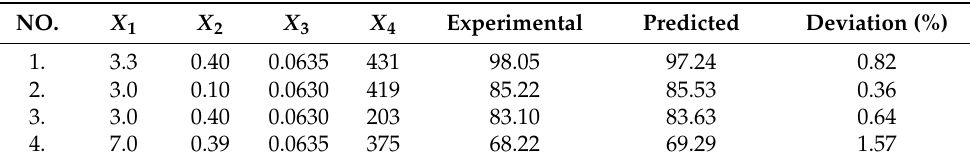
Table 5. The obtained optimum conditions for the photocatalytic degradation of MO using Gd 2 O 3 - ZIF-8